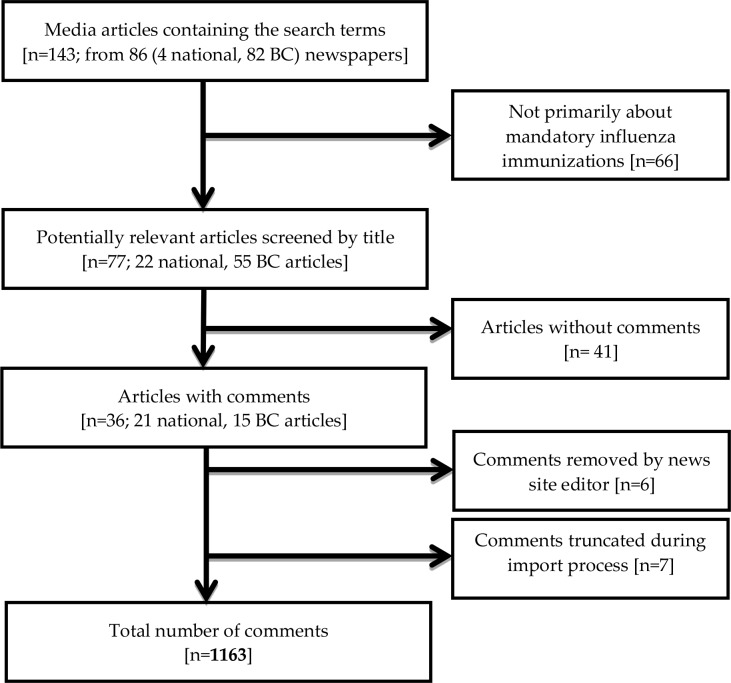
Search strategy and inclusion criteria.An initial search returned 143 articles from which we filtered down to 36 articles containing 1163 comments.